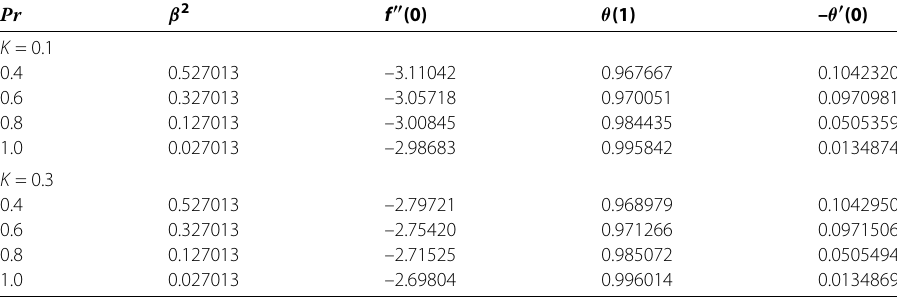
Table 6 Variation of β 2 = ϒ , f (cid:2)(cid:2) (0), θ (1) and – θ (cid:2) (0) using 20th-order HAM via Mathematica